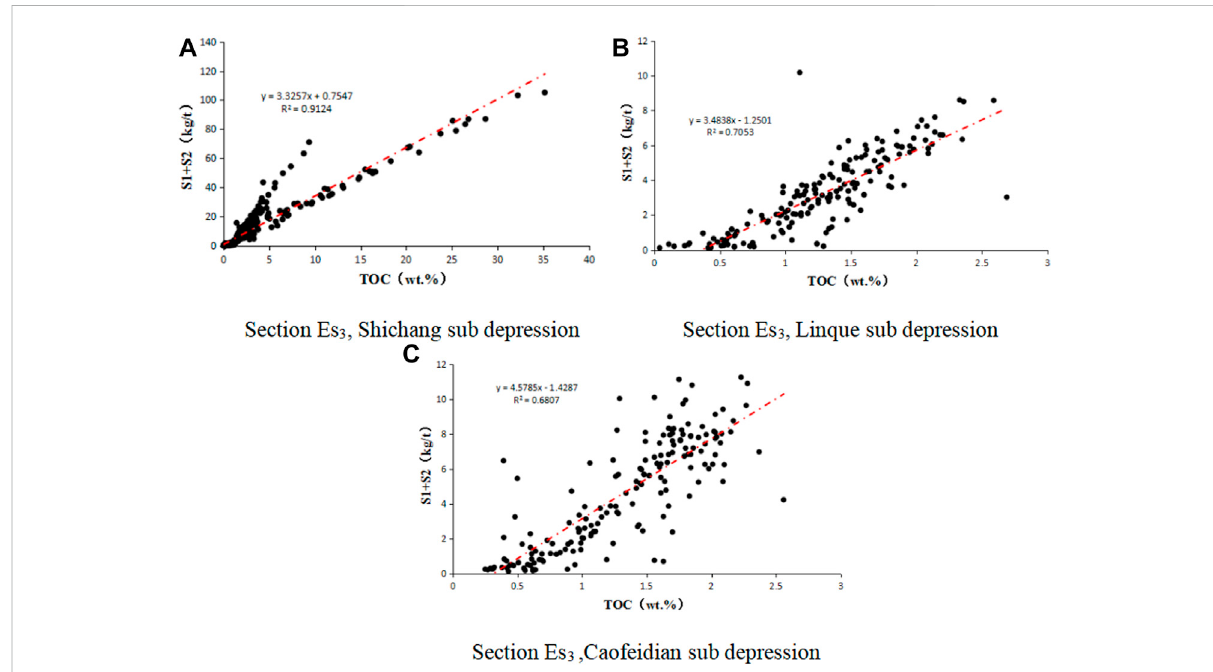
FIGURE 10 CrossplotofmeasuredTOCandS 1 +S 2 ofEs 3 source rocksindifferentsubdepressionsofNanpu Sag. (A) Section Es 3 ,Shichang sub depression. (B) Section Es 3 , Linque sub depression. (C) Section Es 3 , Caofeidian sub